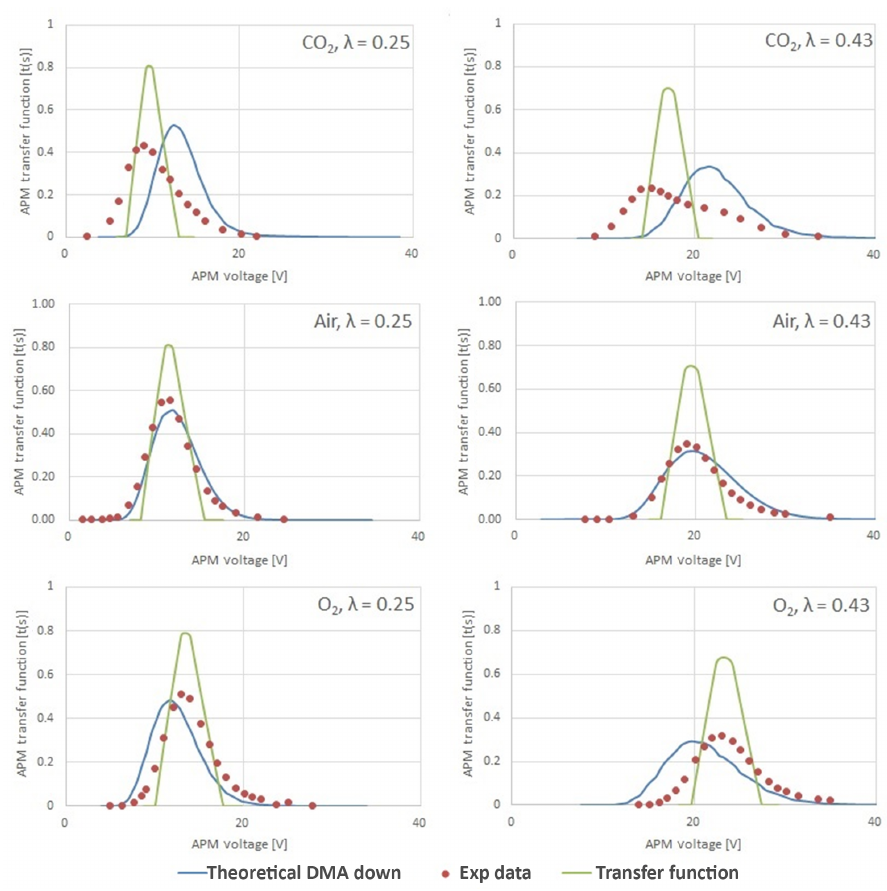
Figure 6. APM transfer function of 50nm PSL spheres for various carrier gases with λ = 0 . 25 and 0.43.